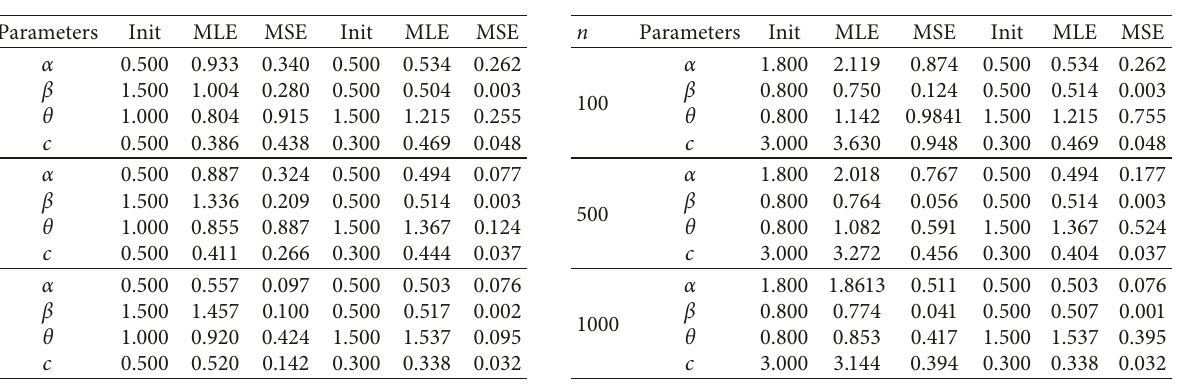
Table 5: MLE and MSE of NDWW distribution for set 5 and set